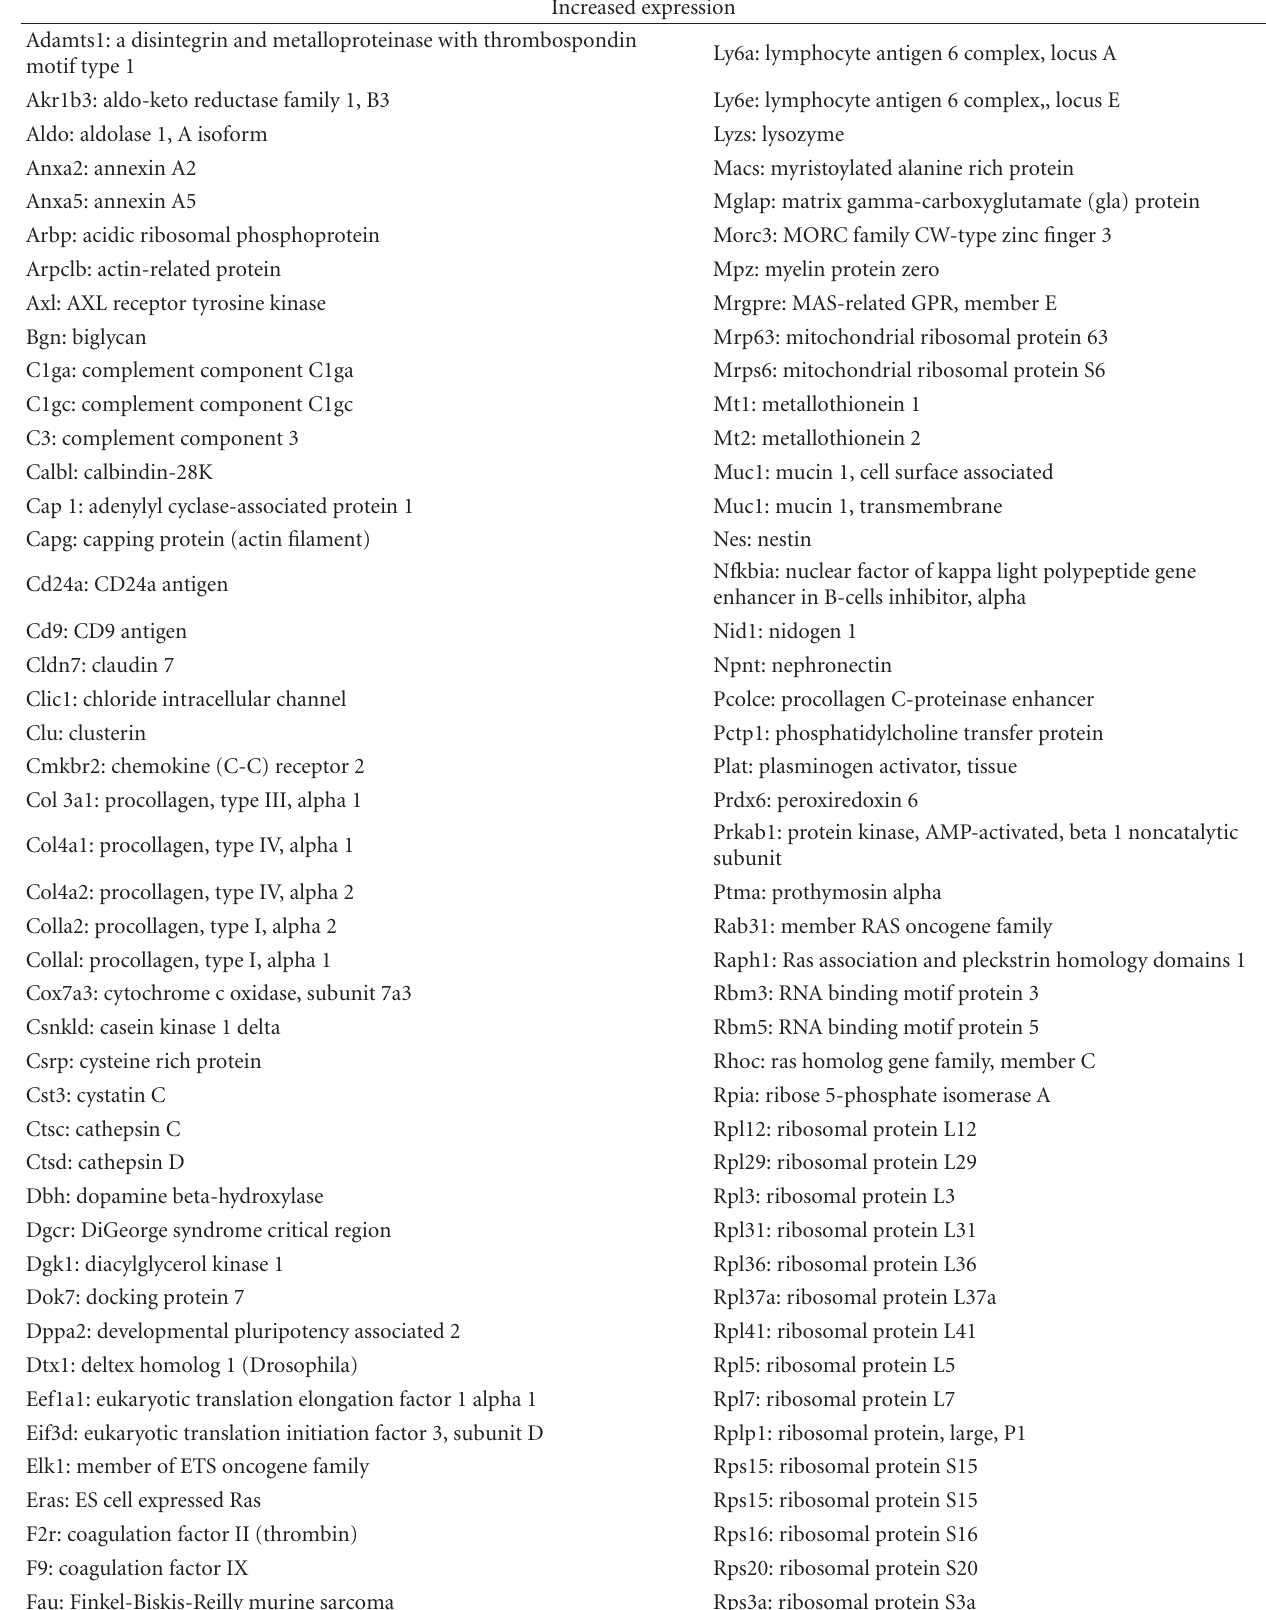
Table 1: The 175 genes with significantly di ff erent expressions in the MN kidneys compared with the normal kidneys. Increased